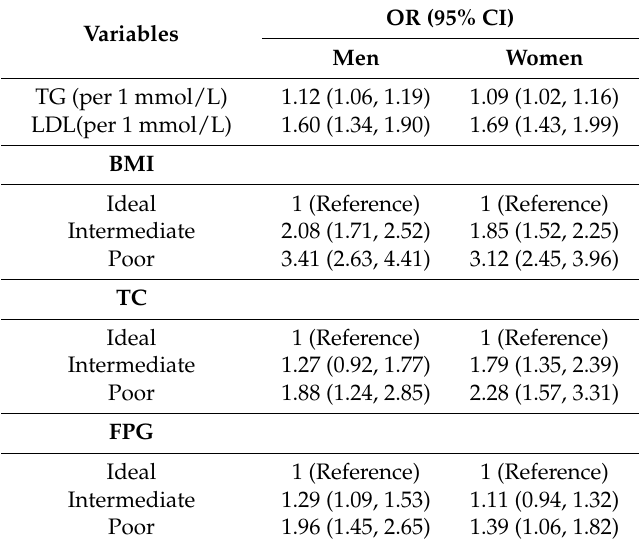
Table 3. Multivariable logistic regression analyses for associations between modifiable risk factors and hypertension accompanied by HHcy classified by gender a